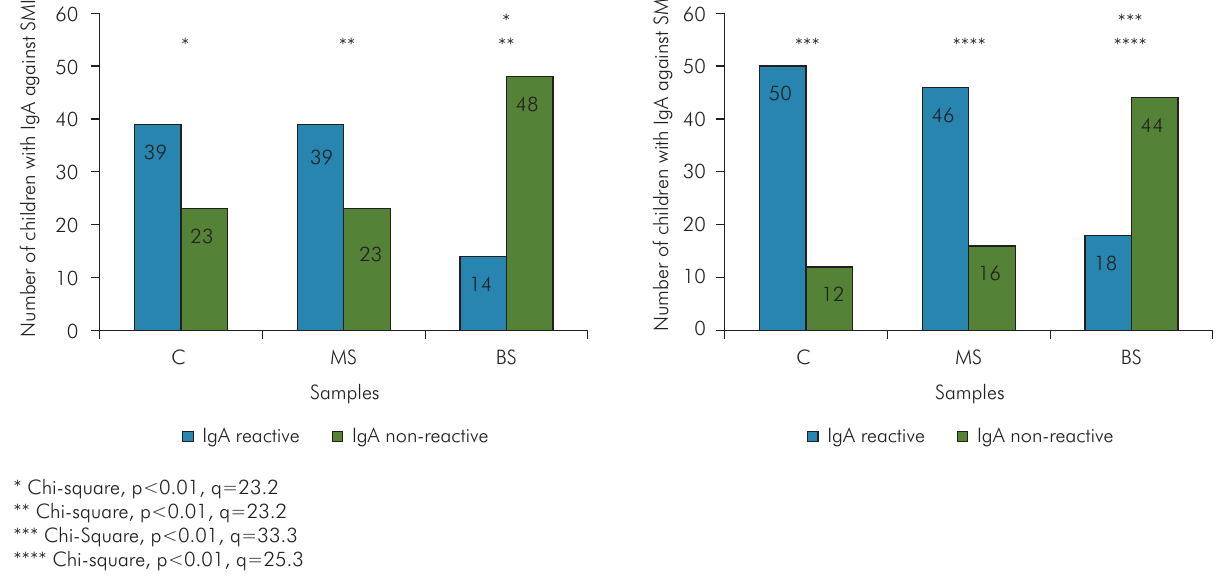
Figure 1. Number of samples in C (colostrum), MS (maternal saliva) and BS (newborn saliva) with IgA reactive or not to SMI ( Streptococcus mitis ) and SM ( S. mutans